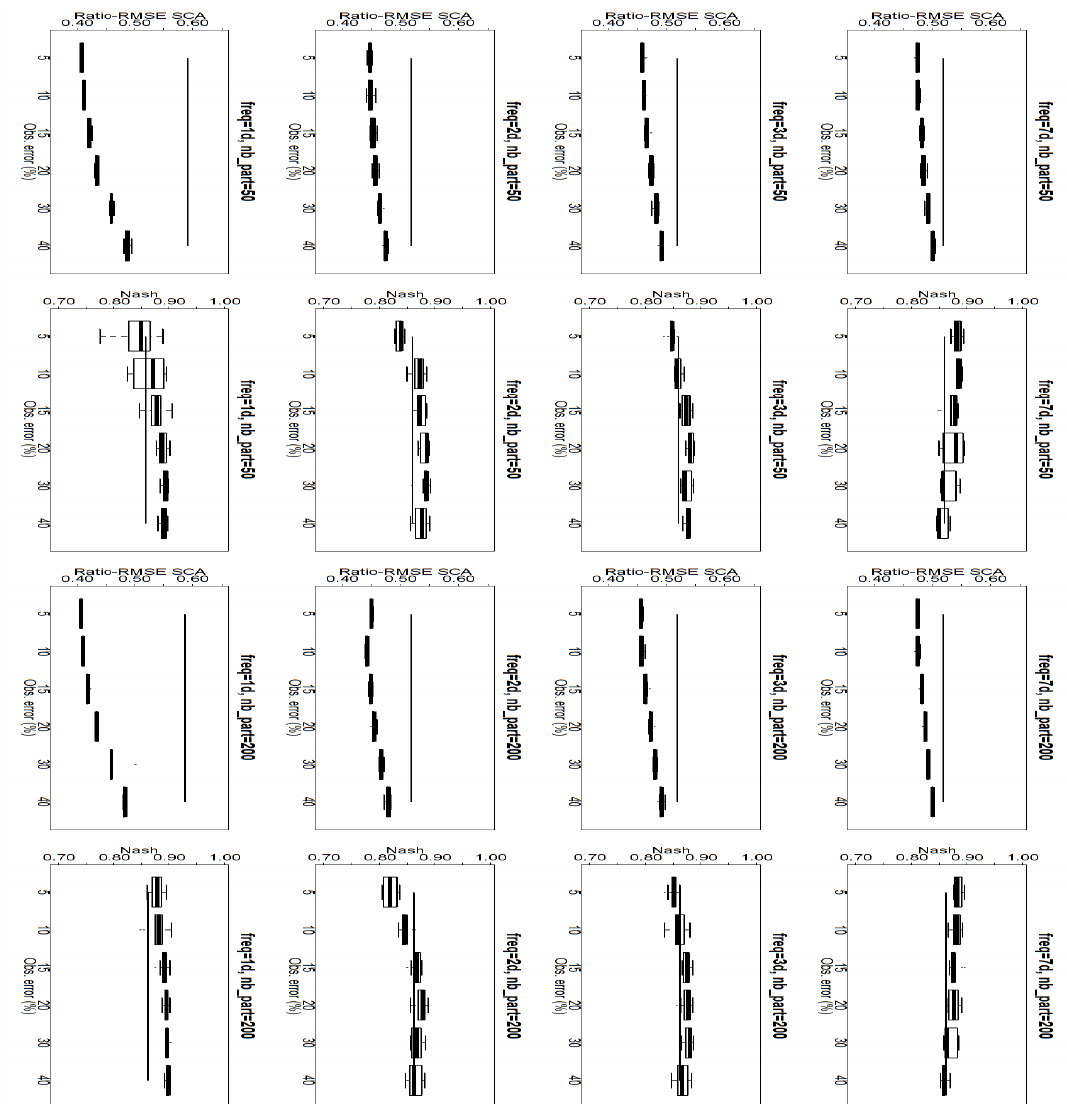
Figure 10. SCA ratio-RMSE and Nash for the real MODIS SCA particle filter experiments on the area upstream of the Kromericz station. The frequency of assimilation (freq) and the number of particles (nb part) are indicated for every panel on the y-axis. The boxplots are drawn for 10 similar-condition experiments. The corresponding no-assimilation experiment is represented with a